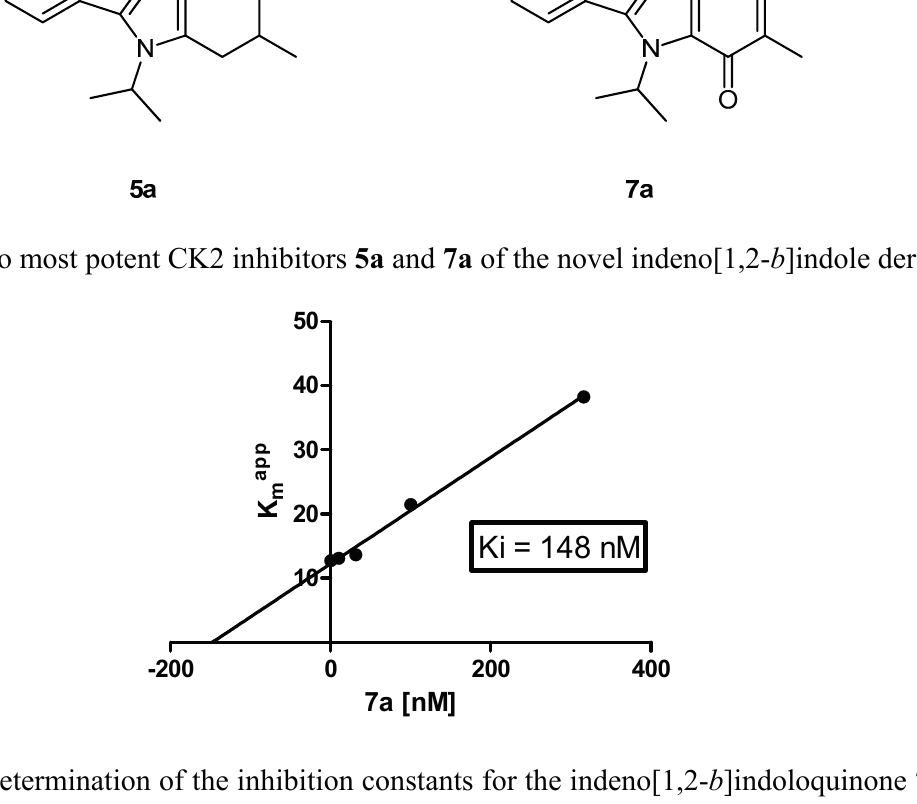
Figure 6. Determination of the inhibition constants for the indeno[1,2- b ]indoloquinone 7a . (cid:1837) (cid:3040)(cid:3028)(cid:3043)(cid:3043) were plotted against the corresponding inhibitor